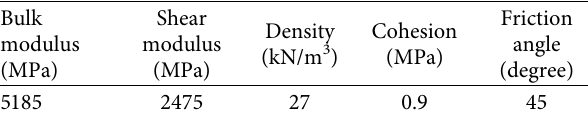
Table 2: Physical and mechanical parameters of rock mass.